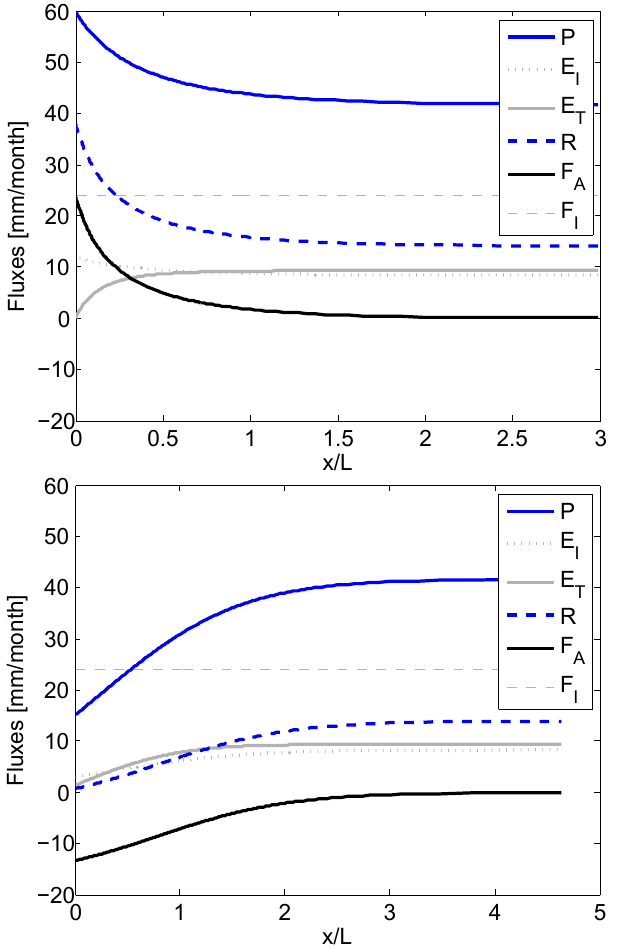
Fig. 4. Relative atmospheric moisture plotted against relative soil moisture filling for the reference case of Table 2 and 4 addi- tional cases (see Table 3), top: for ξ s = 0, bottom: for ξ s = 10 mm month − 1 (note the different y-axis scale). The last two cases corre- spond to a model without the coupling term (1- W ) in Eq. (13) and with P given as a linear function of W